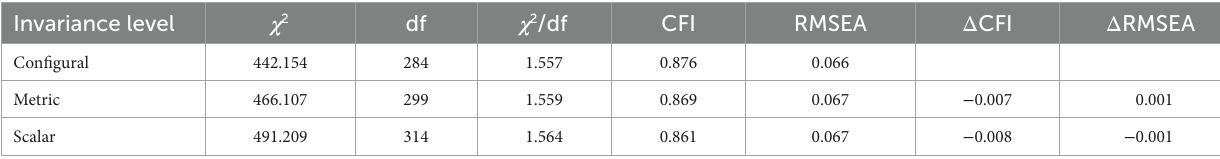
TABLE 1 Invariance testing across gender group.